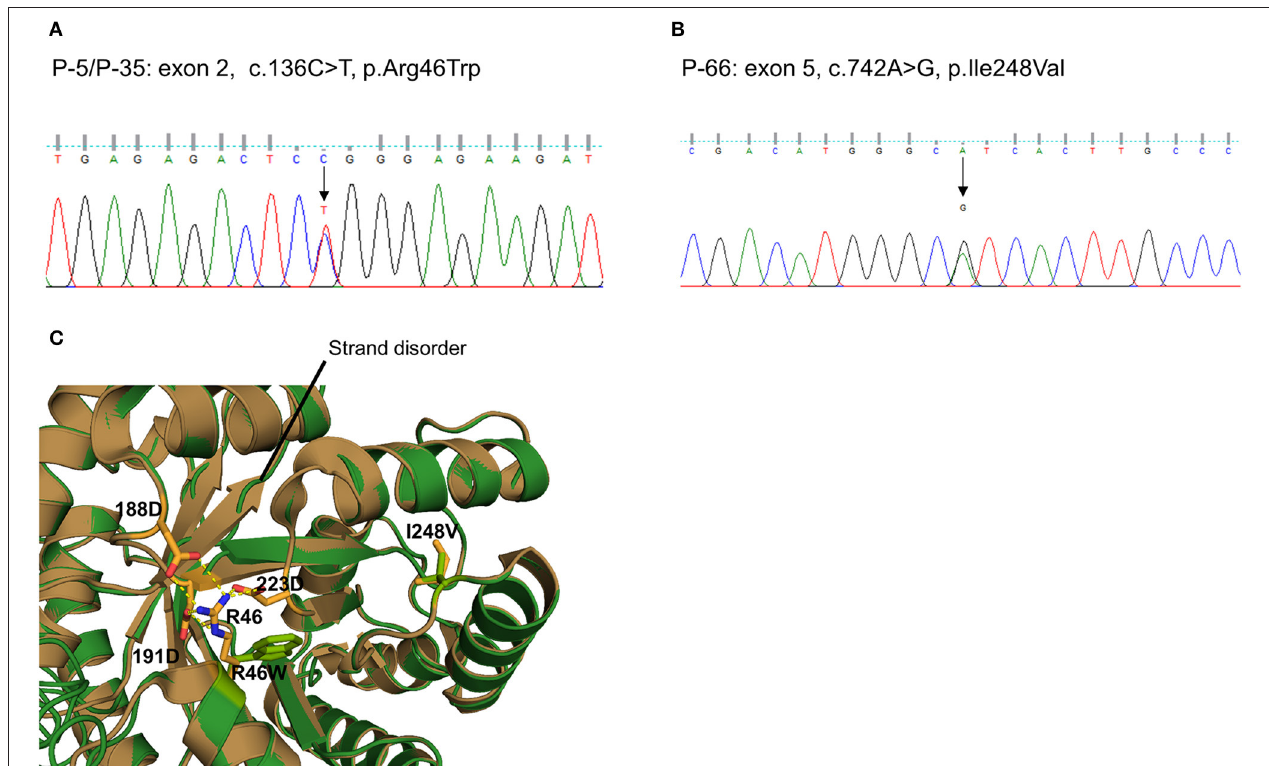
FIGURE 3 | Sequencing results and protein structural modeling of the rare variants in MTHFR identified by targeted next-generation sequencing. The chromatograms show two rare heterozygous variants: (A) one is a missense rare variant in exon 2 causing the substitution of highly conserved arginine by tryptophan at position 46 (c.136C > T, p.R46W, P-5/P-35); (B) another is also a missense rare variant in exon 5 causing the substitution of highly conserved isoleucine by valine at position 248 (c.742A > G, p.I248V, P-66). (C) Protein structural modeling shows that p.R46W variant may cause breakage of salt bridges with side chains of p.D188, p.D223,